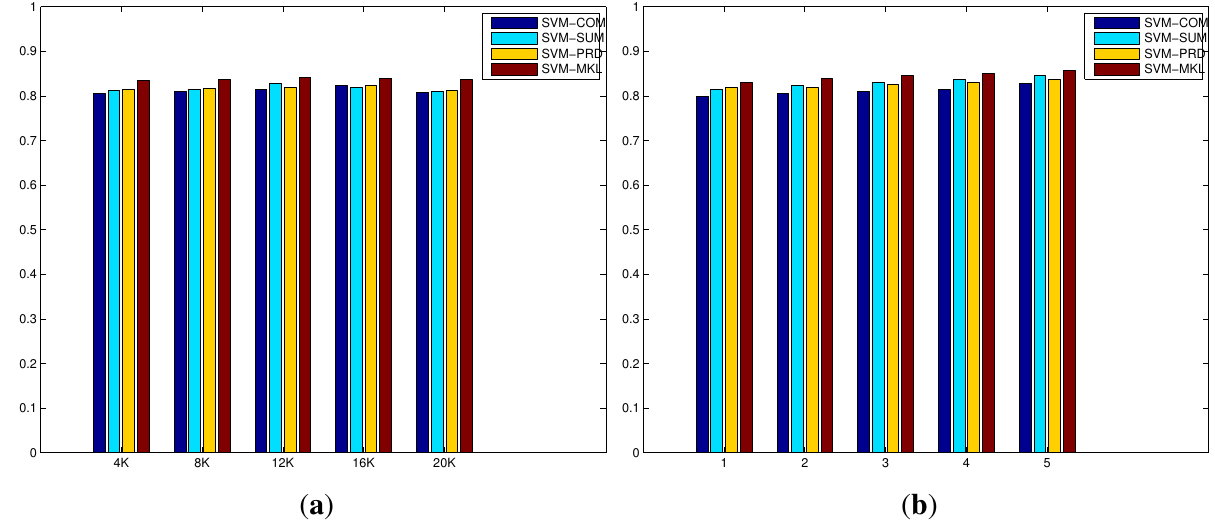
Figure 6. Performance comparisons on the ACT42 dataset, of proposed methods, with respect to the size of BoWs (from 4 K to 20 K when the number of layers of mSDA is 5) and the number of layers of mSDA (from 1 to 5 when the size of BoWs is 4 K), in terms of average recognition rates. ( a ) The size of BoWs; ( b ) The number of layers of